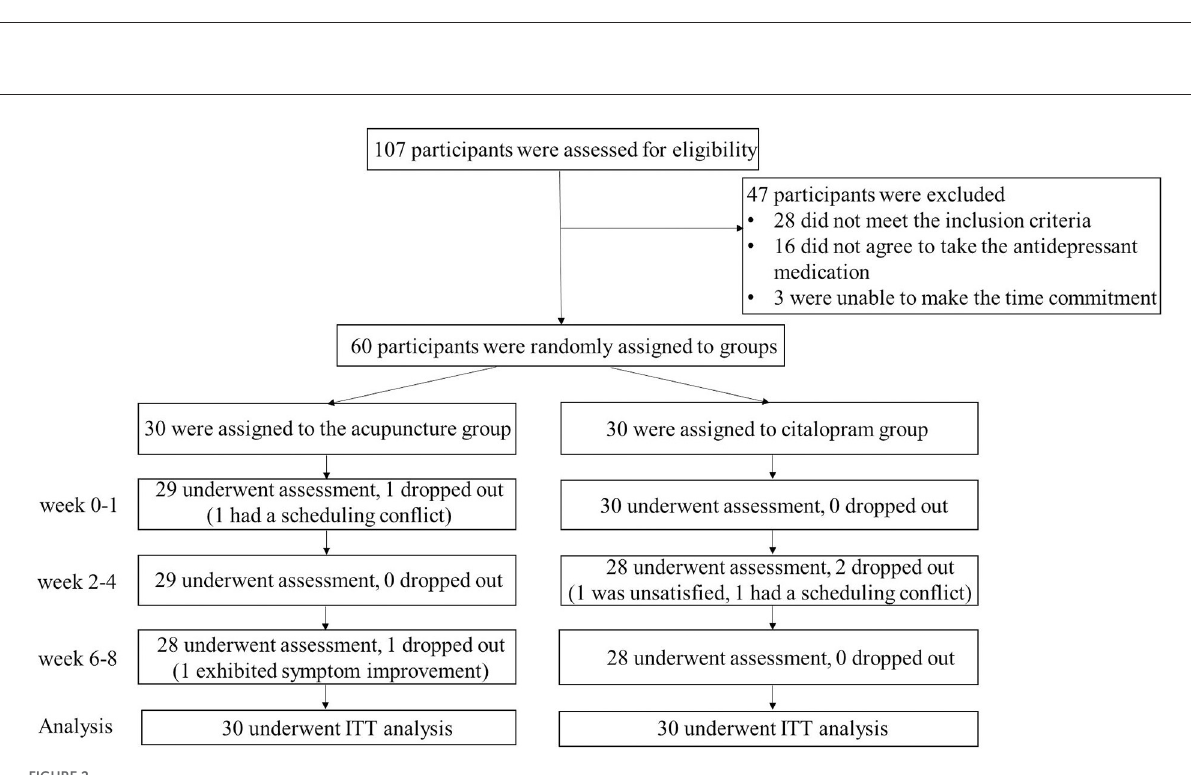
FIGURE2 CONSORT chart. ITT, Intention-to-treat.